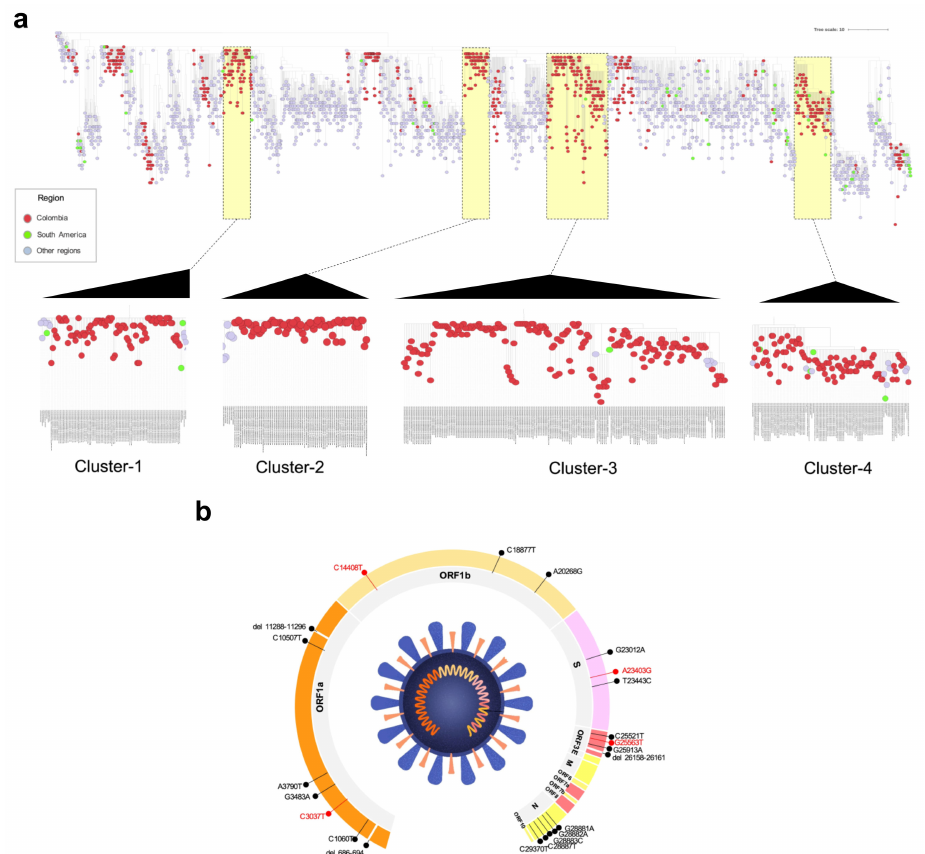
Figure 3. Phylogenetic analysis of global SARS-CoV-2 isolates and nucleotide diversity of the Colombian genomes. ( a ) Phylogenetic relationships between the 2623 genome sequences analyzed, which include the 774 Colombian genomes. ( b ) Position of each of SNP within the SARS-CoV-2 genome, to compare the 774 Colombian isolates and the Wuhan reference sequence (NC_045512). The SNPs found in more than 50% of the genomes analyzed are highlighted in